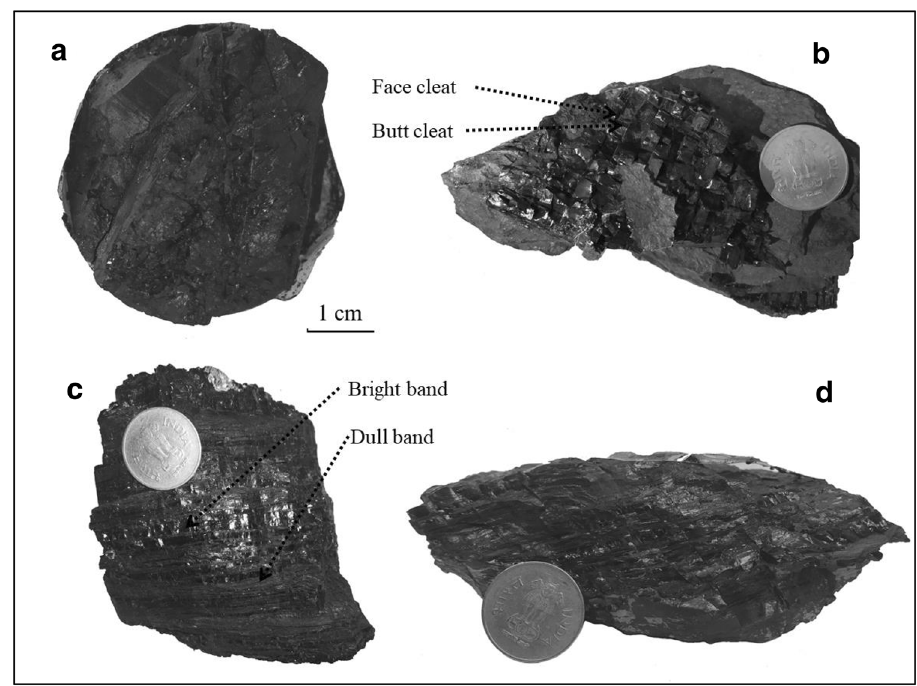
Fig. 4 Coal samples collected from the study area with a , b different intensities of cleat formation; c , d alternate bright bands and dull bands in coal samples Table 1 Summary of the proximate analysis report of the collected samples from multiple seams at different depths Mine/block